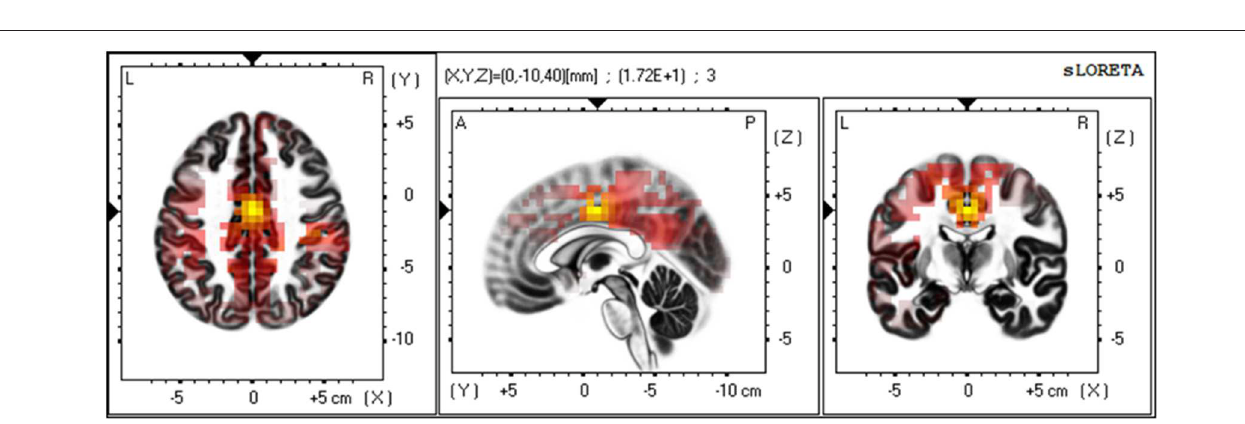
FIGURE 6 | Current source estimation of the low-beta oscillation via LORETA. A group comparison of low beta-band current source density (CSD) for the point at which participants received the outcome of the RPS game (Win/Lose via t -test and SnPM randomization) revealed a statistically significant difference at the cingulate cortex [ t (15) = 17.18, p < 0.01. MNI coordinate: X = 0, Y = − 10, Z = 40, BA24]. The yellow color indicates significantly higher levels of current density when the “cheered” for player